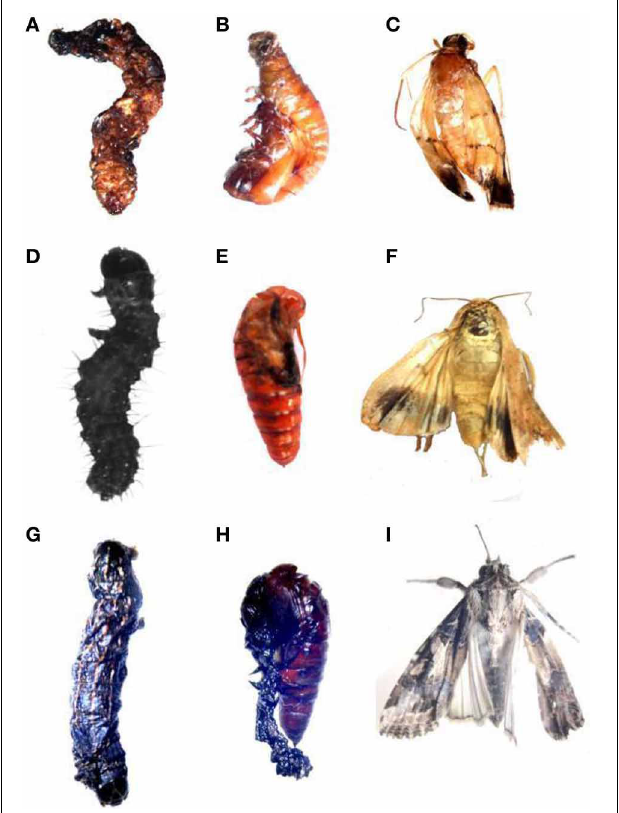
FIGURE 7 | Larval deformities of Lepidopteran insects after treatment with 0.5 ppm of Azadirachtin. (A–C) C. medinalis larval, pupal and adult deformities. (D–F) H. armigera larval, pupal and adult deformities. (G–I) S. litura larval, pupal and adult